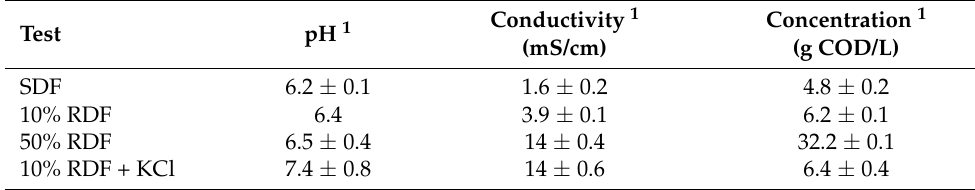
Table 3. Characteristics of the synthetic and the real dark fermentation wastewaters (SDF, RDF) used as MFC